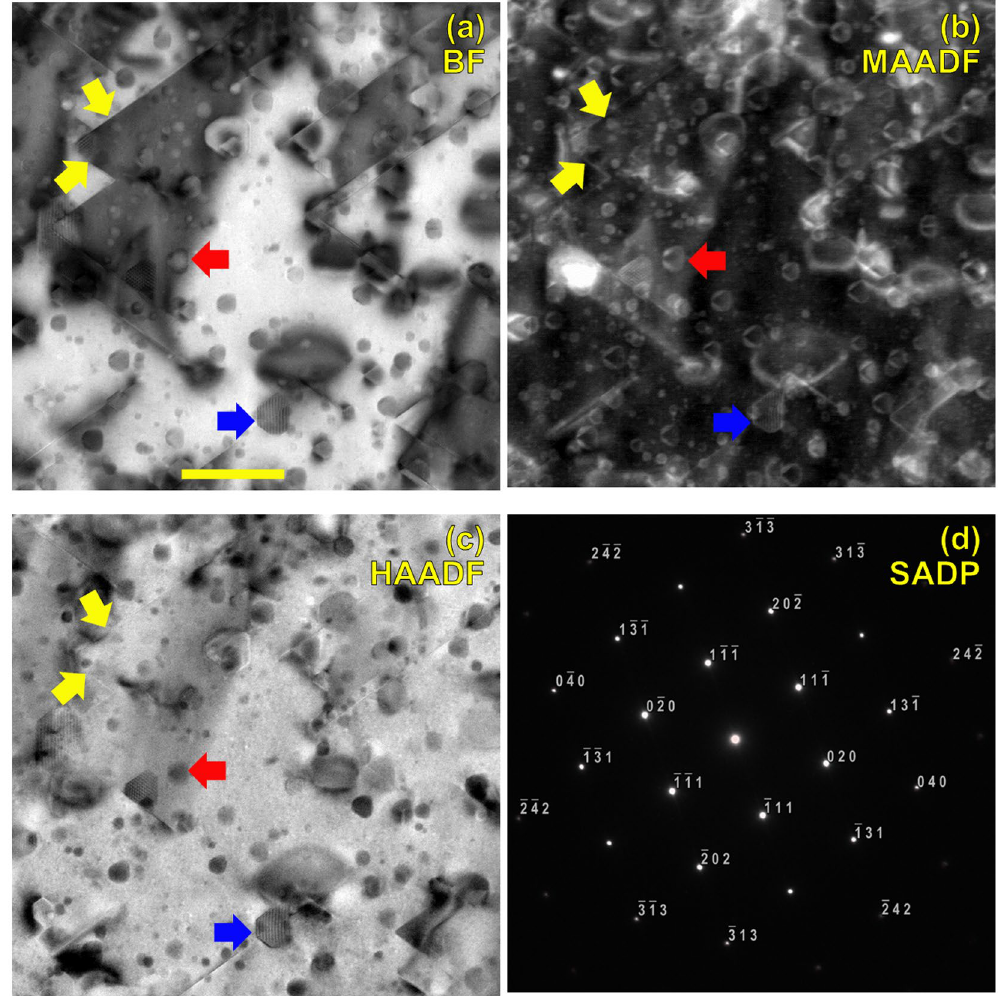
Figure 1. ( a ) Bright field, ( b ) medium-angle annular dark-field, and ( c ) high-angle annular dark field STEM images on the [101] zone axis. ( d ) Selected-area diffraction pattern. Yellow arrows denote 11-1 and -111 Frank loops. Red arrows denote a tetragonal void with strong diffraction contrast. Blue arrow denotes a region of second-phase material. Scale bar: 50